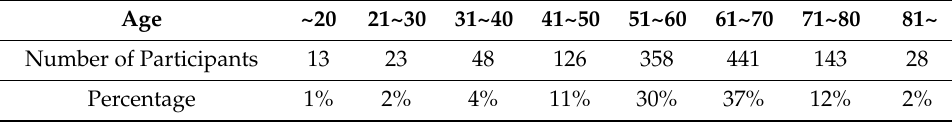
Table 3. The age distribution of questionnaire